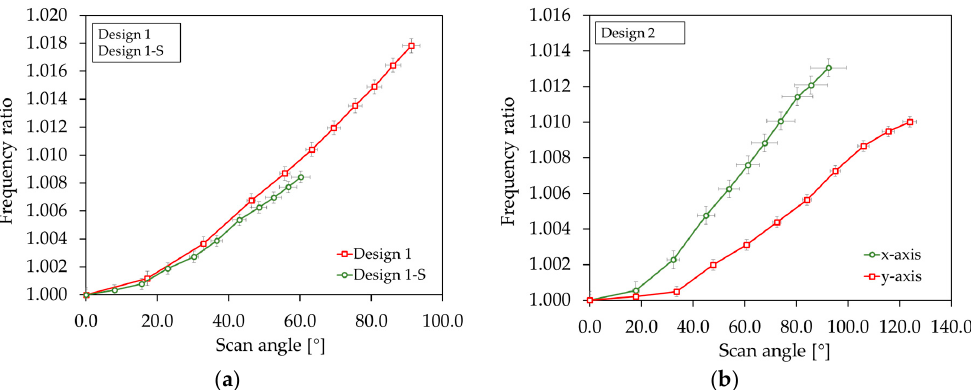
Figure 23. Frequency ratio versus scan angle: ( a ) Design 1 and Design 1-S; ( b ) Design 2. The x- and y-axis error bar is the median absolute deviation.